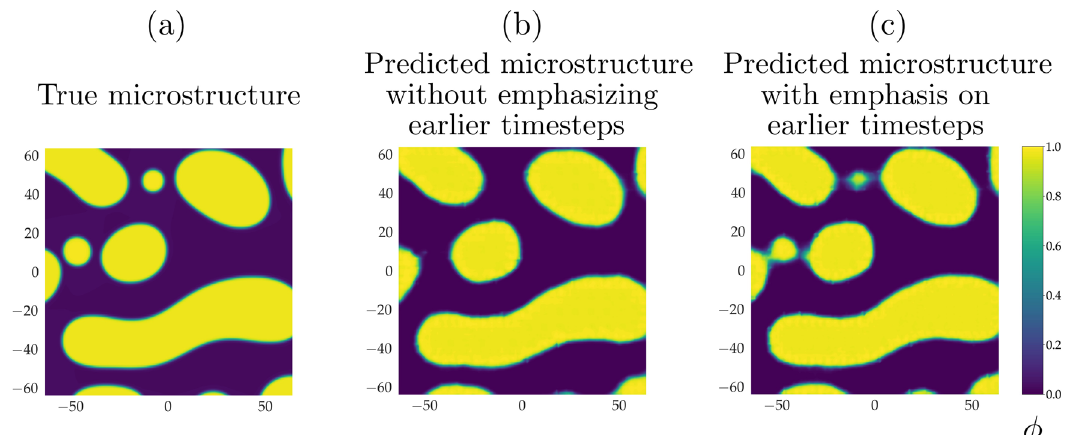
Fig. 5 Capturing small microstructural features at earlier time steps. a True microstructure at t = t 10 . b Predicted microstructure without emphasizing earlier time steps during training. c Microstructure predicted by DeepONet trained on a dataset where the earlier time steps where repeated to increase the importance given to earlier time